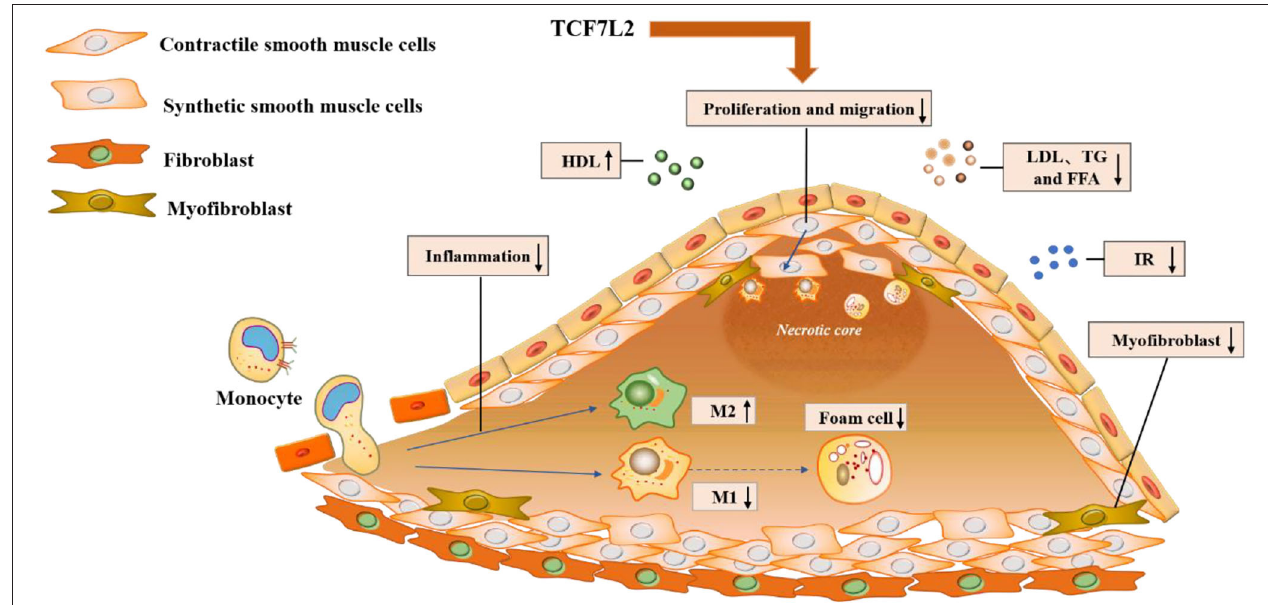
FIGURE 4 | Molecular mechanisms underlying the action of TCF7L2 in anti-atherosclerosis. TCF7L2 exerts a protective role in atherosclerosis through multiple molecular mechanisms, including the inhibition of inflammation, VSMC proliferation and migration, dyslipidemia, insulin resistance, and foam cell and myofibroblast